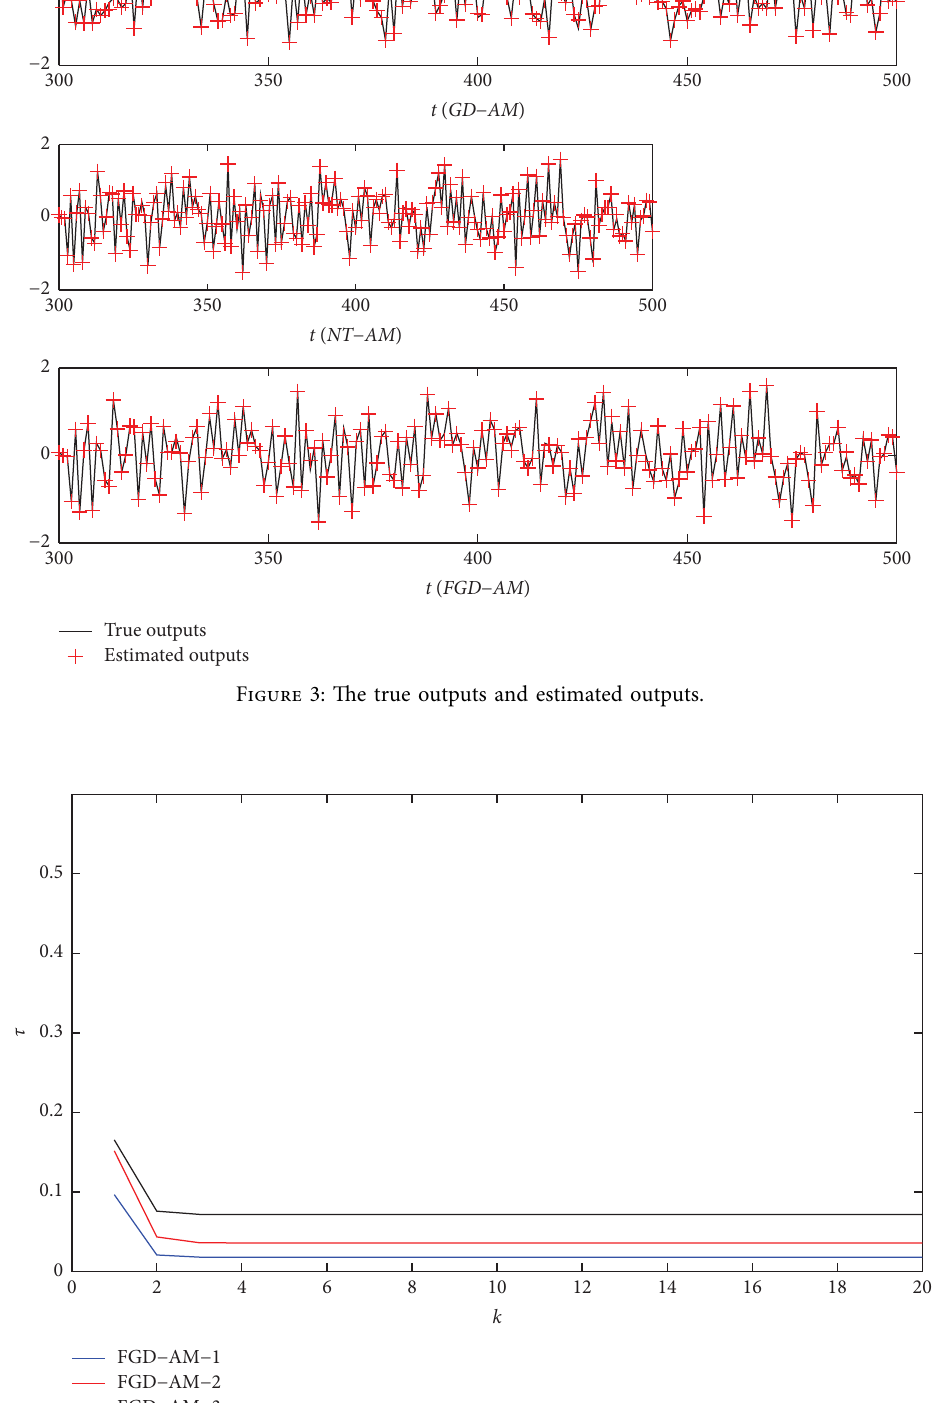
Figure 4: Te parameter estimation errors with diferent noise-to-signal